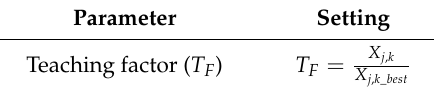
Table 5. Cases of the five selected serial and parallel configurations and the shading situations.